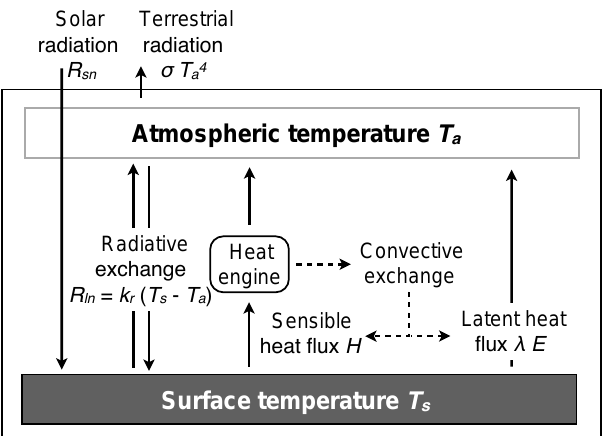
Figure 2. Land–atmosphere energy balance scheme for derivation of atmospheric demand adapted after Kleidon et al.